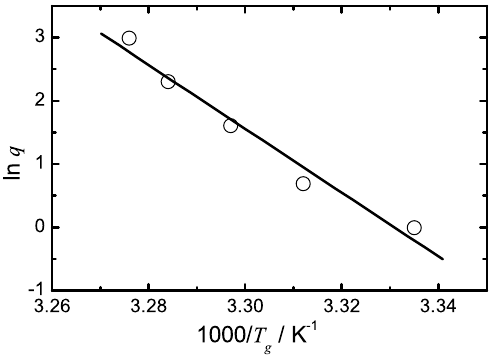
Figure 7. Arrhenius plot of lnq vs. 1 =T for simvastatin ( r 2 = 0 : 963